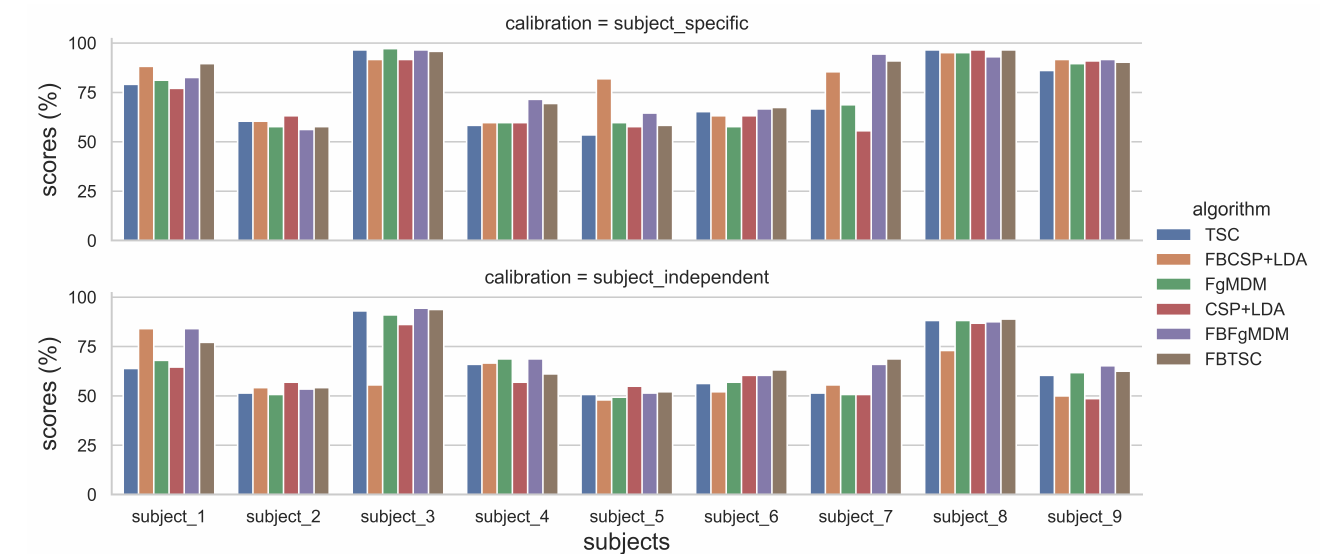
Figure 5. Classification accuracy of each algorithm, for each subject, on the “BCI competition IV data set 2a”, in both subject-specific and subject-independent calibrations.